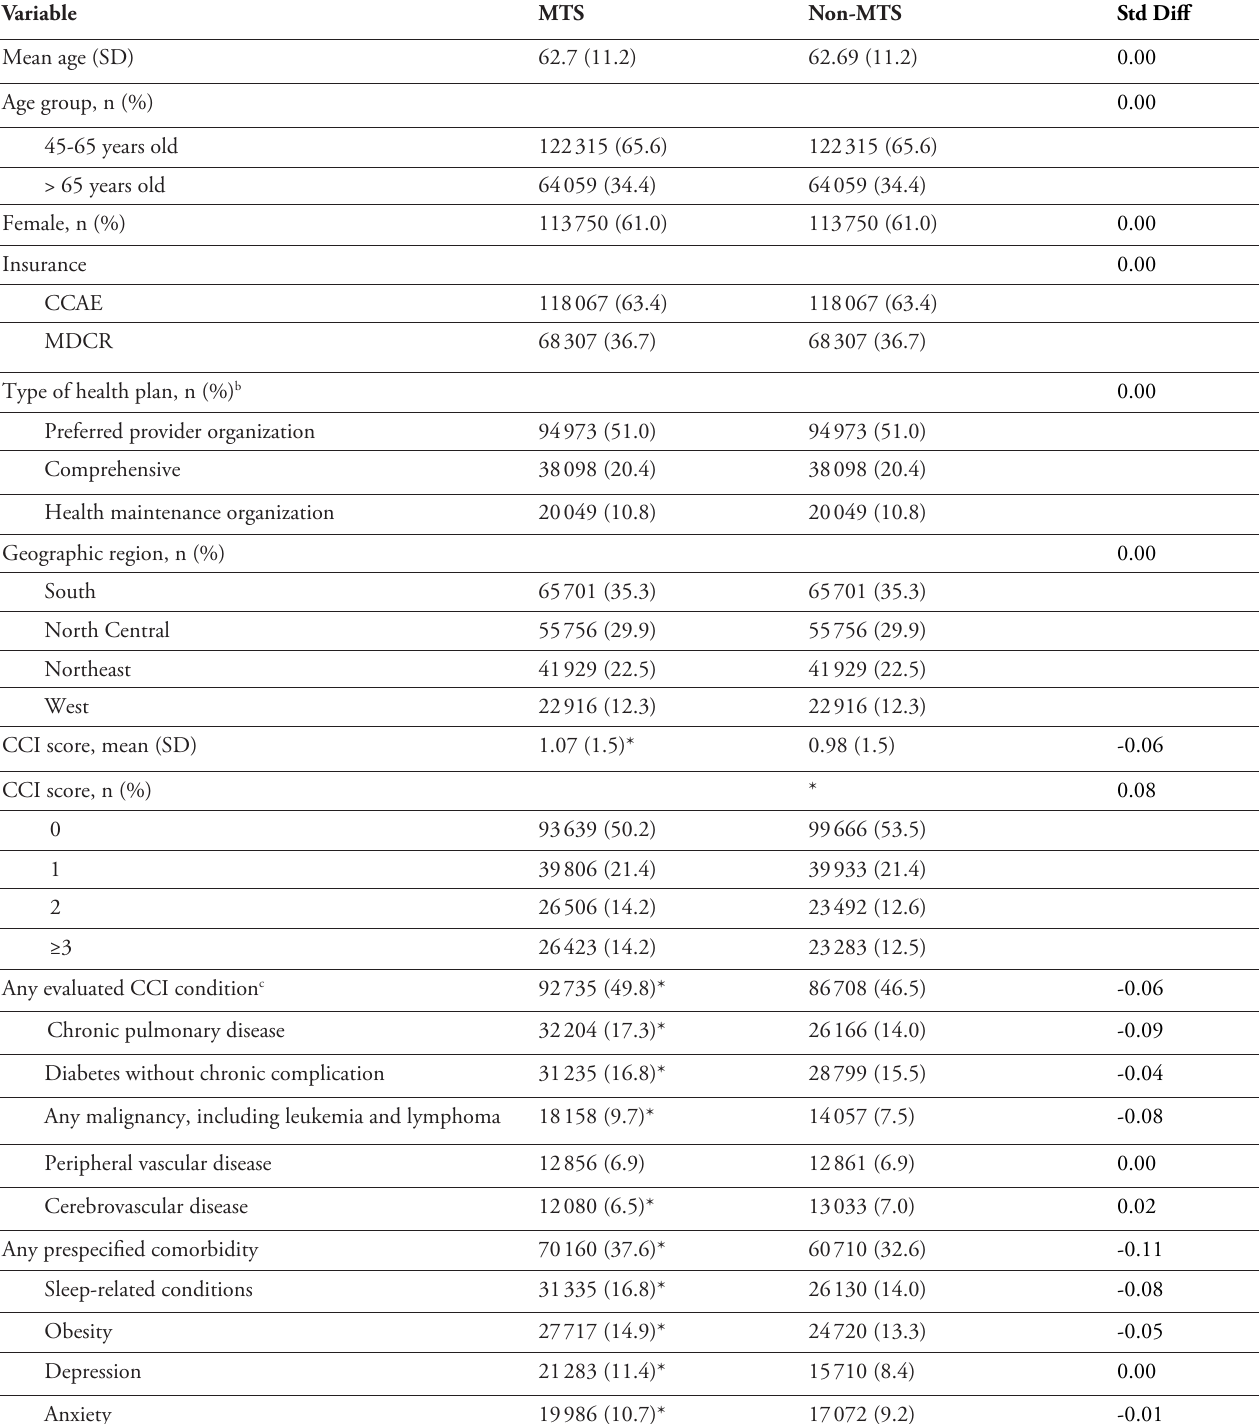
Table 1. Patient Demographics and Clinical Characteristics for Propensity Score–Matched Cohorts